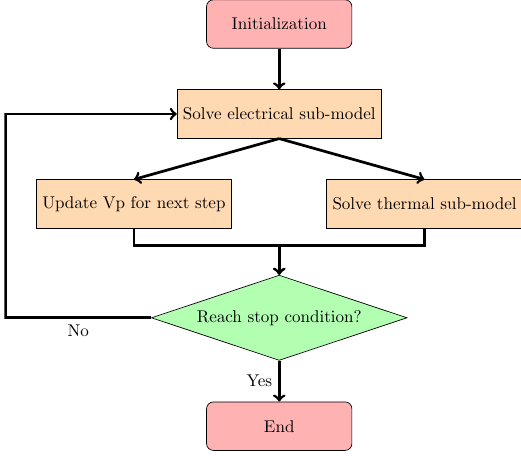
Figure 11. The flow chart of the solving method.